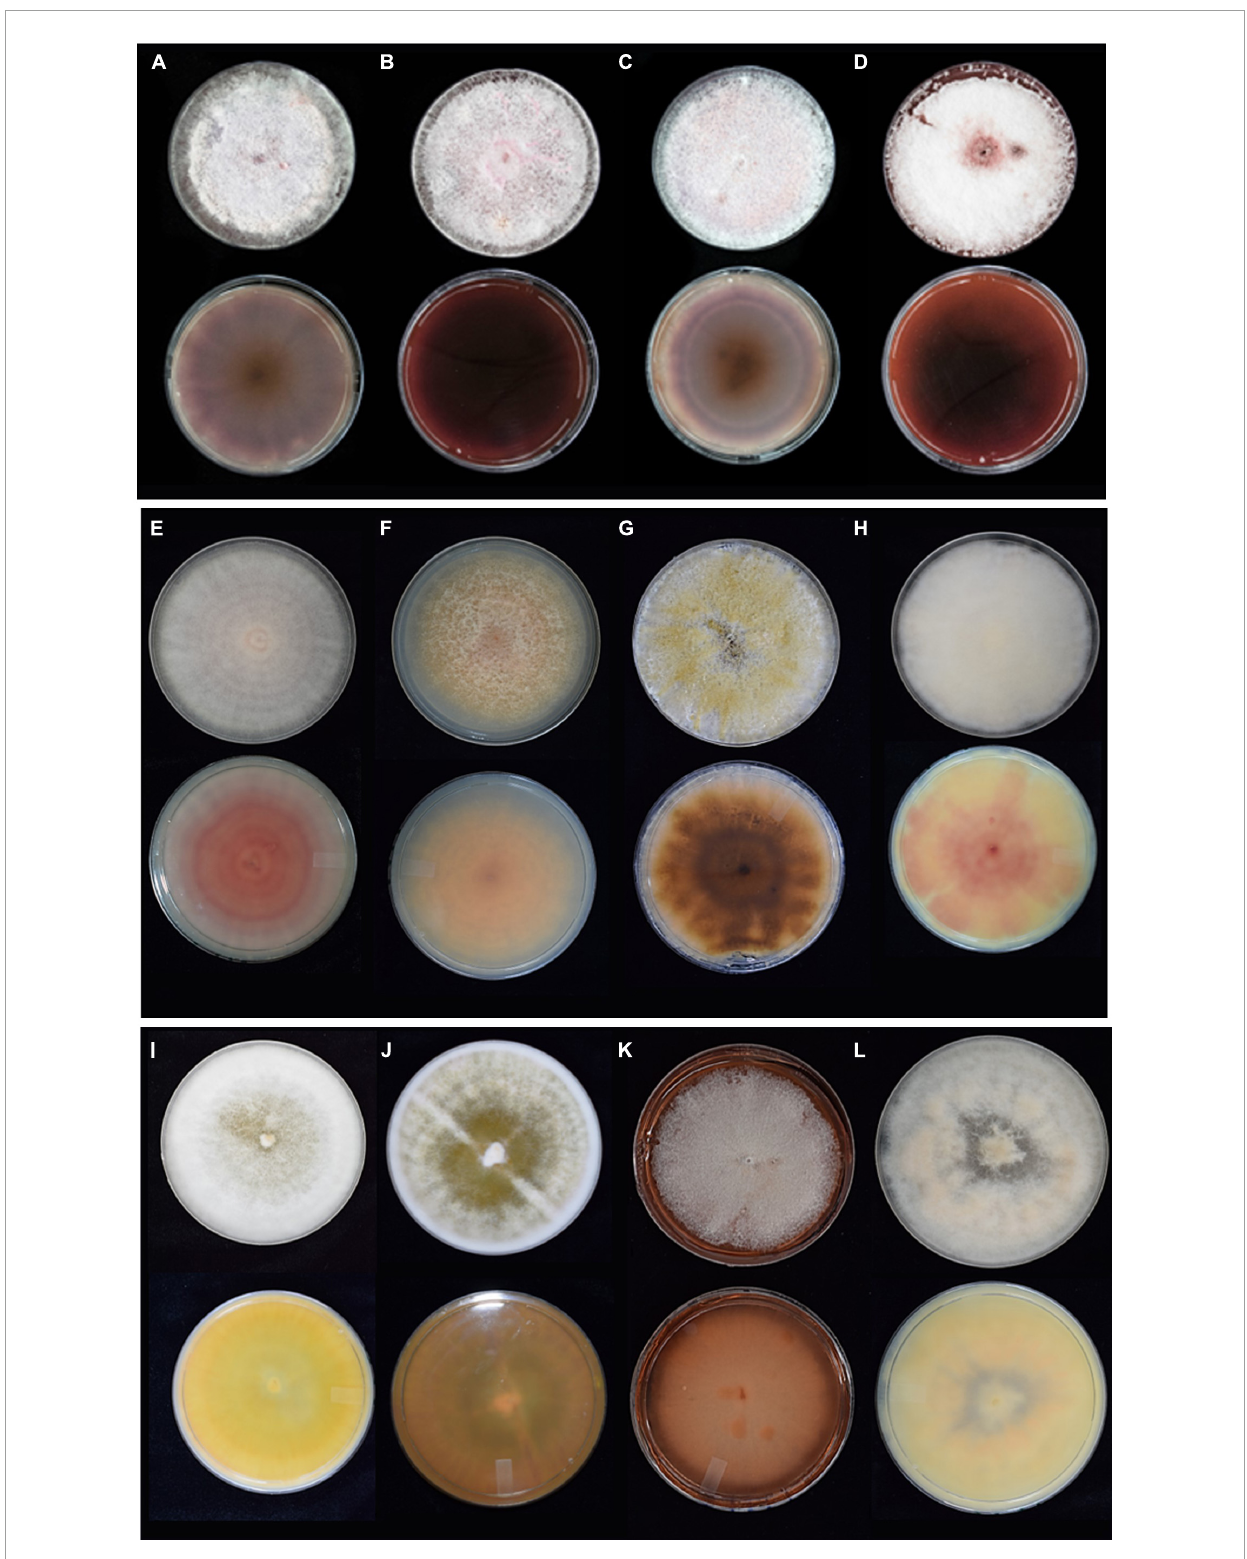
FIGURE2 The gross morphology growth (top row) and colony pigmentation (bottom row) for representative isolates of the different species complexes cultured on PDA for 10 days. (A) FOSC (PPRI 25045), (B) FOSC (PPRI 25046), (C) FOSC (PPRI 25504), (D) FOSC (PPRI 25049), (E) FFSC (PPRI 27410), (F) FFSC (PPRI 27540), (G) FSSC (PPRI 25506), (H) FCSC (PPRI 26282), (I) FSAMSC (PPRI 26792), (J) FSAMSC (PPRI 27530), (K) FIESC (PPRI 25500), and (L) FIESC (PPRI